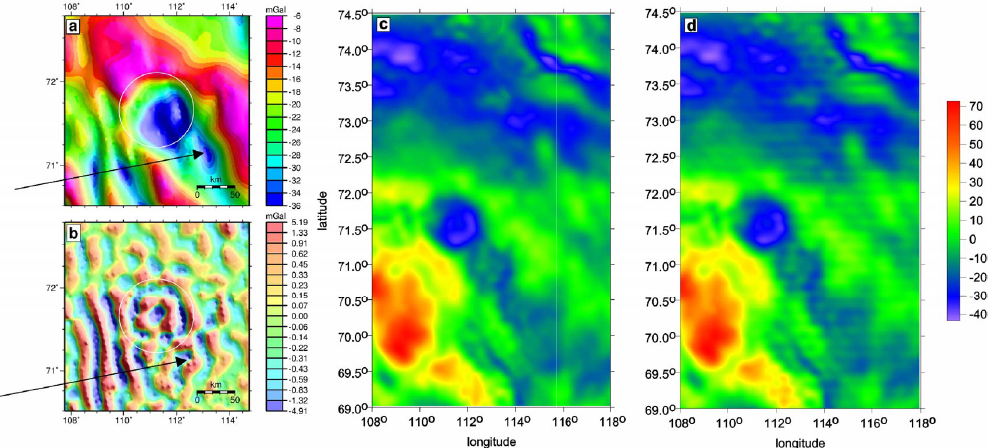
Fig. 6. Gravity anomalies (Bouguer’s) over the Popigai region (data courtesy GETECH Ltd); reproduced from Fig. 3a of Pilkington et al. (2002), here panel (a) . White circles represent estimated crater at 100km diameter. The high-pass filtered gravity anomalies to retain wavelength component < 50km, panel (b) . The arrows show locations of possible impact crater Popigai II. Gravity anomalies computed with DNSC08, resolution 2 × 2 0 , panel (c) , as compared to those with EGM2008, resolution 5 × 5 0 – panel (d) , see also Fig. 2).